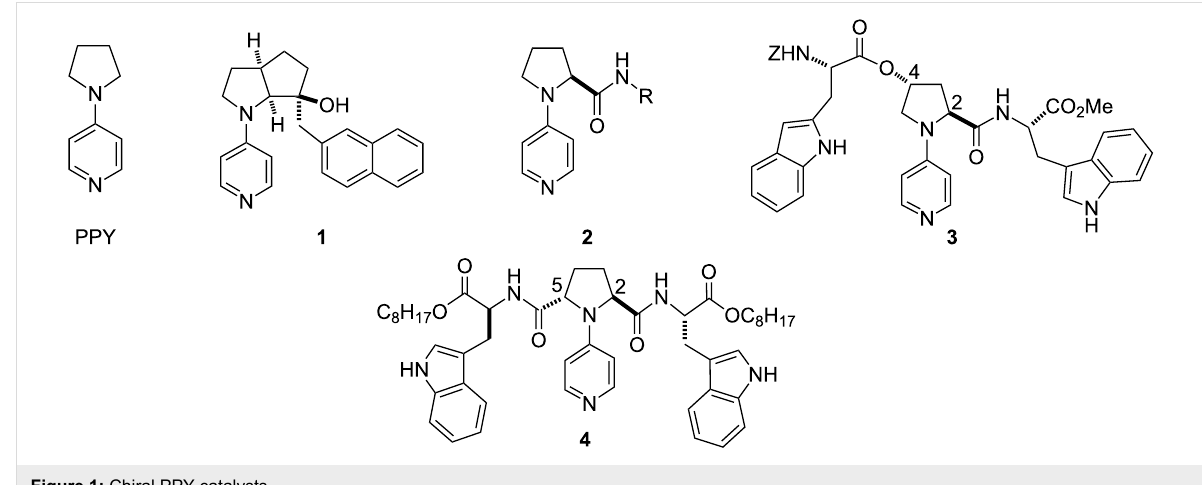
Figure 1: Chiral PPY catalysts.